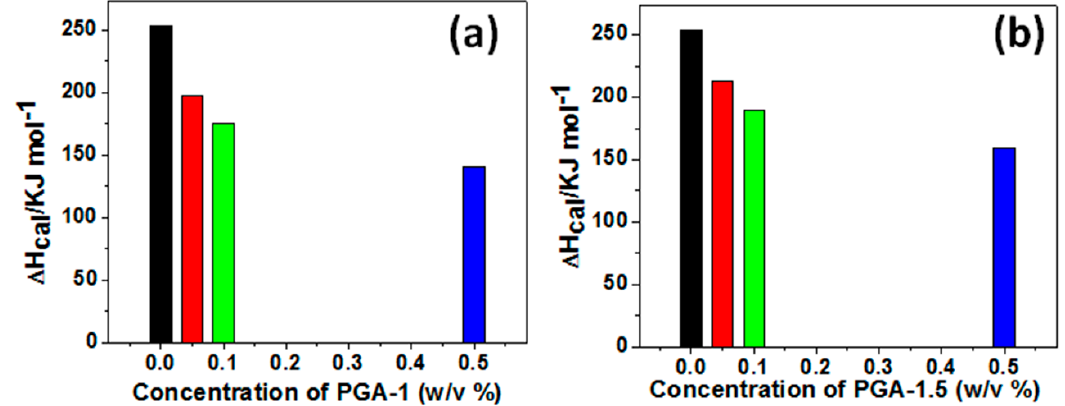
Figure 4. The changes in Δ H cal of BSA upon addition of PGA-1 ( a ); and PGA-1.5 ( b ) at various concentrations.